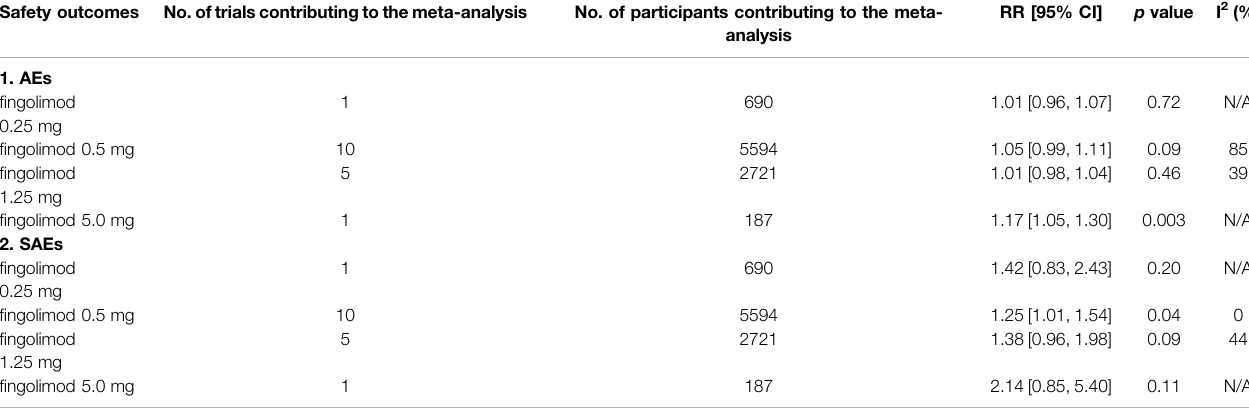
TABLE 3 | Effects sizes from meta-analysis of safety outcomes; from all trials using random effects models. Safety outcomes